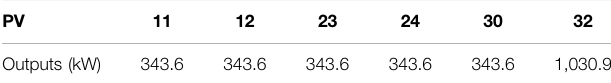
TABLE 5 | Actual outputs of PVs under the proposed method.